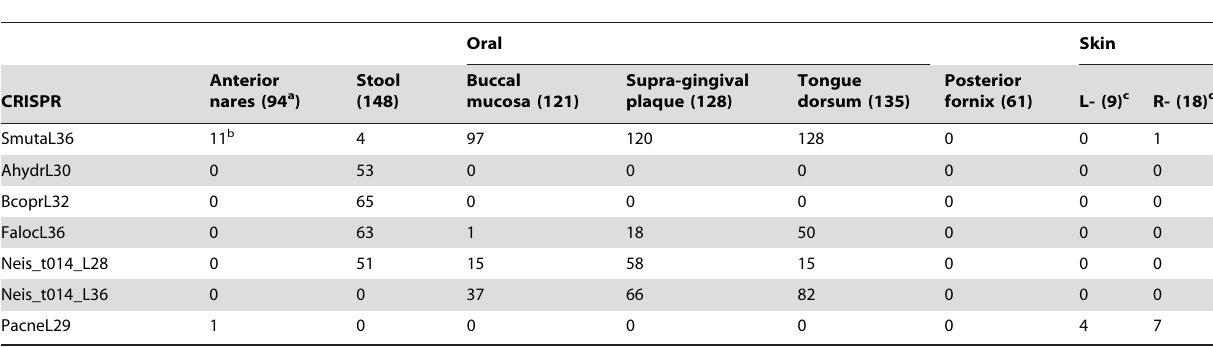
Table 3. Distribution of selected CRISPRs across body